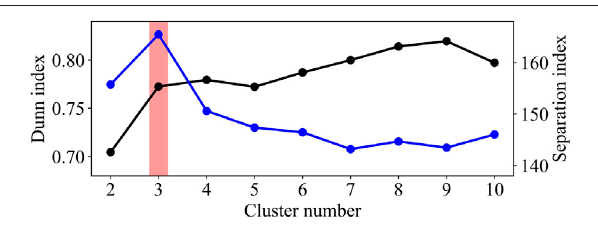
FIGURE 2 | Evaluation indexes at each cluster number. The black line and dots refer to the Dunn index, and the blue line and dots refer to the Separation index. The red band refers to cluster number = 3, which has the optimal clustering effect. FIGURE3| TimeseriesoftheTCgenesiscountinthethreeclasses.The